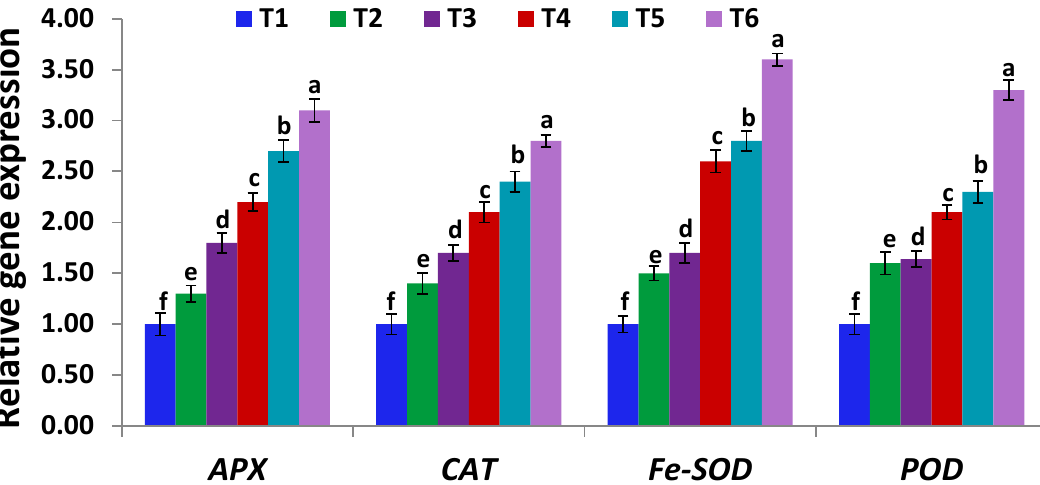
Figure 3. Expression levels of APX, CAT, Fe-SOD, and POD genes in leaves of un-inoculated and inoculated soybean plants with Serratia marcescens BM1 under Cd stress. Data are means ± SE ( n = 4). Di ff erent letters (a–f) above the chart columns indicate significant di ff erences between treatments ( p ≤ 0.05). T1, control with no Cd and BM1 treatment; T2, plant treated with Serratia marcescens BM1; T3, plant treated with 150 µ M CdCl 2 ; T4, plant treated with 150 µ M CdCl 2 and Serratia marcescens BM1; T5, plant treated with 300 µ M CdCl 2 ; T6, plant treated with 300 µ M CdCl 2 and Serratia marcescens BM1. Overall, cadmiumstress-inducedoxidative e ff ectshave negativeimpacts ongas